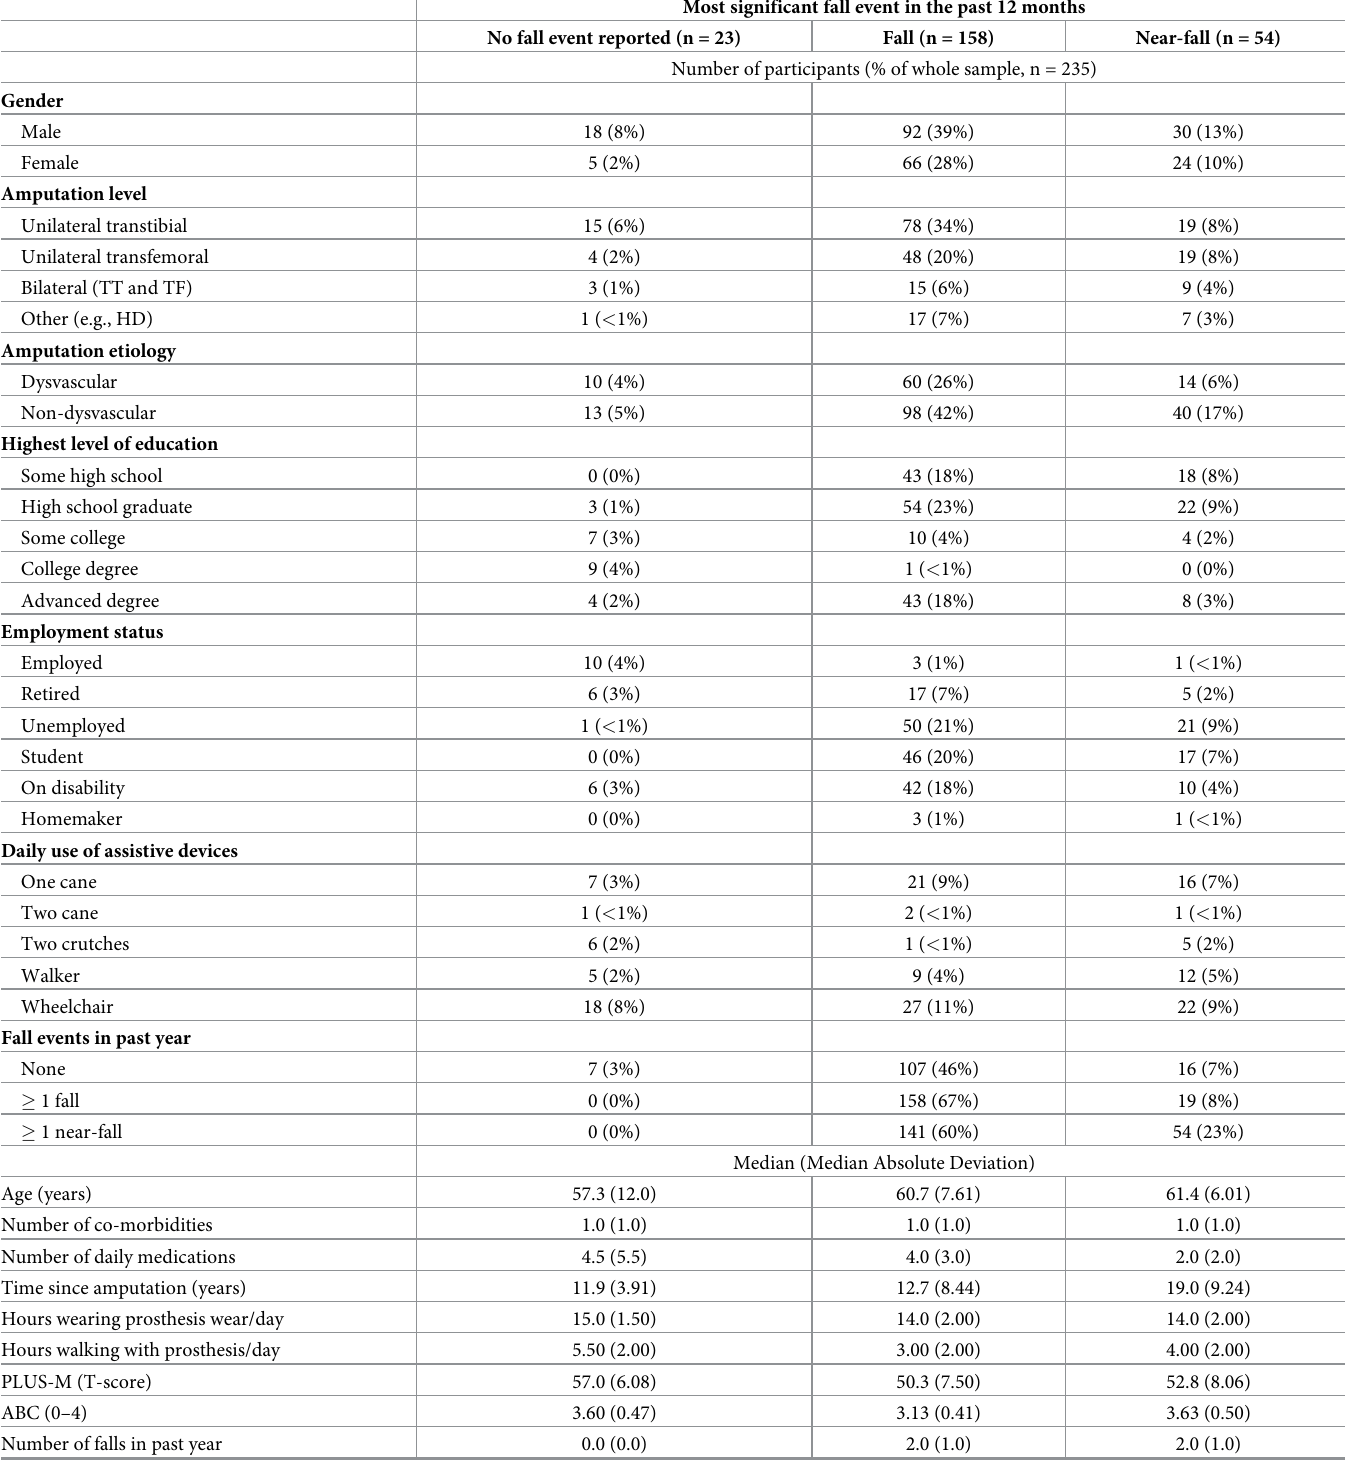
Table 3. Preliminary validation study participant characteristics (n =